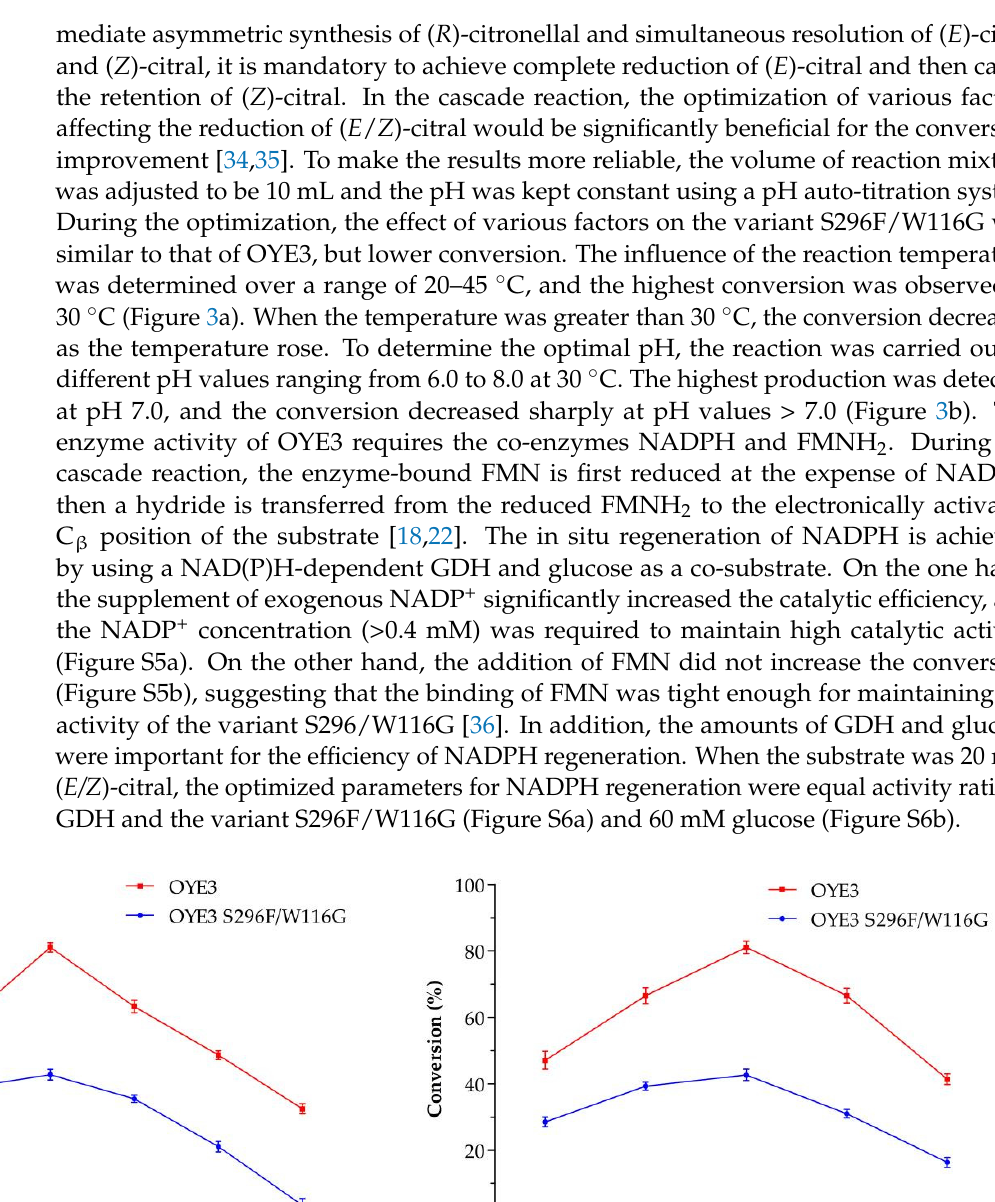
( b ) Figure 4. Time courses of asymmetric reduction of ( E/Z )-citral to ( R )-citronellal. ( a ) OYE3 and GDH as biocatalyst; ( b ) the variant OYE3 S296F/W116G and GDH as biocatalyst. The standard reaction mixture (10 mL) contained 20 mM ( E/Z )-citral, 0.4 mM NADP + , 0.15 U/mL GDH, 50 mM glucose, 0.15 U/mL of the variant S296F/W116G, and 50 mM PIPES buffer solu- tion (pH 7.0). The stock solution of substrate was 200 mM citral dissolved in isopropanol. The reaction was conducted in a reactor with a pH auto-titration system at 400 rpm and 30 ℃ for 12 h (OYE3) or 18 h (the variant S296F/W116G). Data present mean values ± SD from three independent experiments. ( E / Z )-citral contained 58.4% geranial and 41.6% neral. 3. Materials and Methods 3.1. Genes, Organisms, and Chemicals The genes encoding OYE3 and glucose dehydrogenase from Exiguobacterium sibiri- cum were codon-optimized and then synthesized by Tsingke Biotechnology Co., Ltd. (Hangzhou, China) (Figure S7). The pET28b expression vector was used for over-expres- sion of the enzyme OYE3 and GDH, and the E. coli strain BL21(DE3) was used as the host. E. coli cultures were grown routinely in Luria Bertani (LB) medium at 37 ℃ for 12 h.